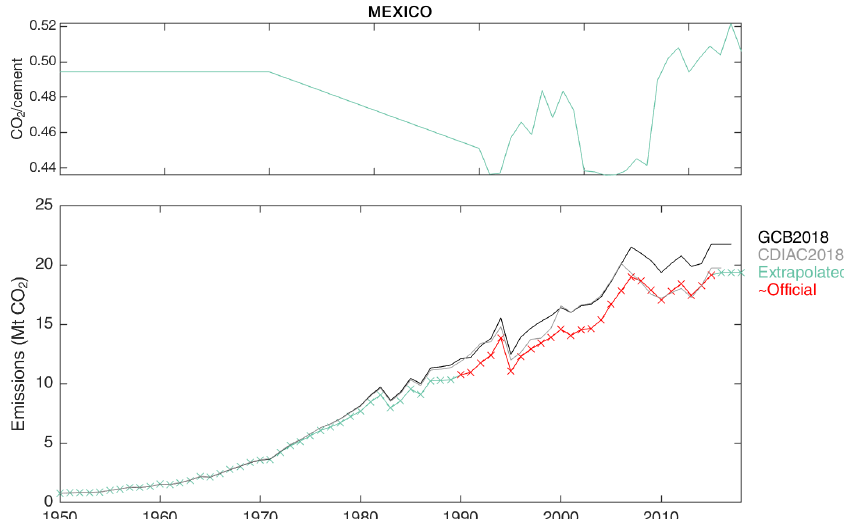
Figure C29. Revised cement emissions for Mexico.